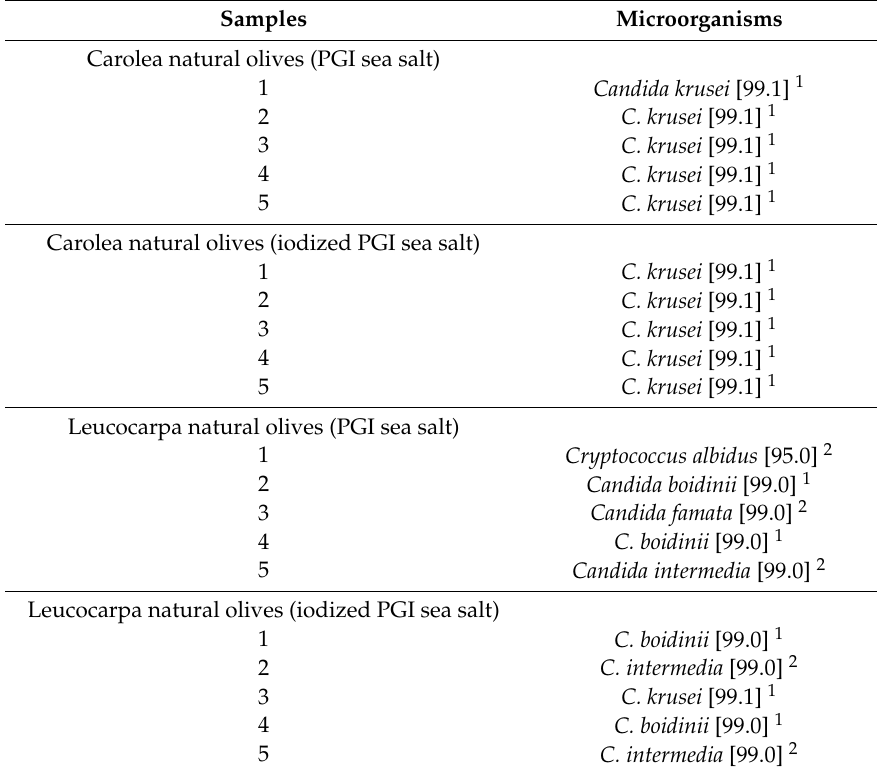
Table 7. Tentative identification of the isolated yeasts. Identification percentages are shown between parentheses. 1 API 20 C AUX; 2 RapID Yeast Plus